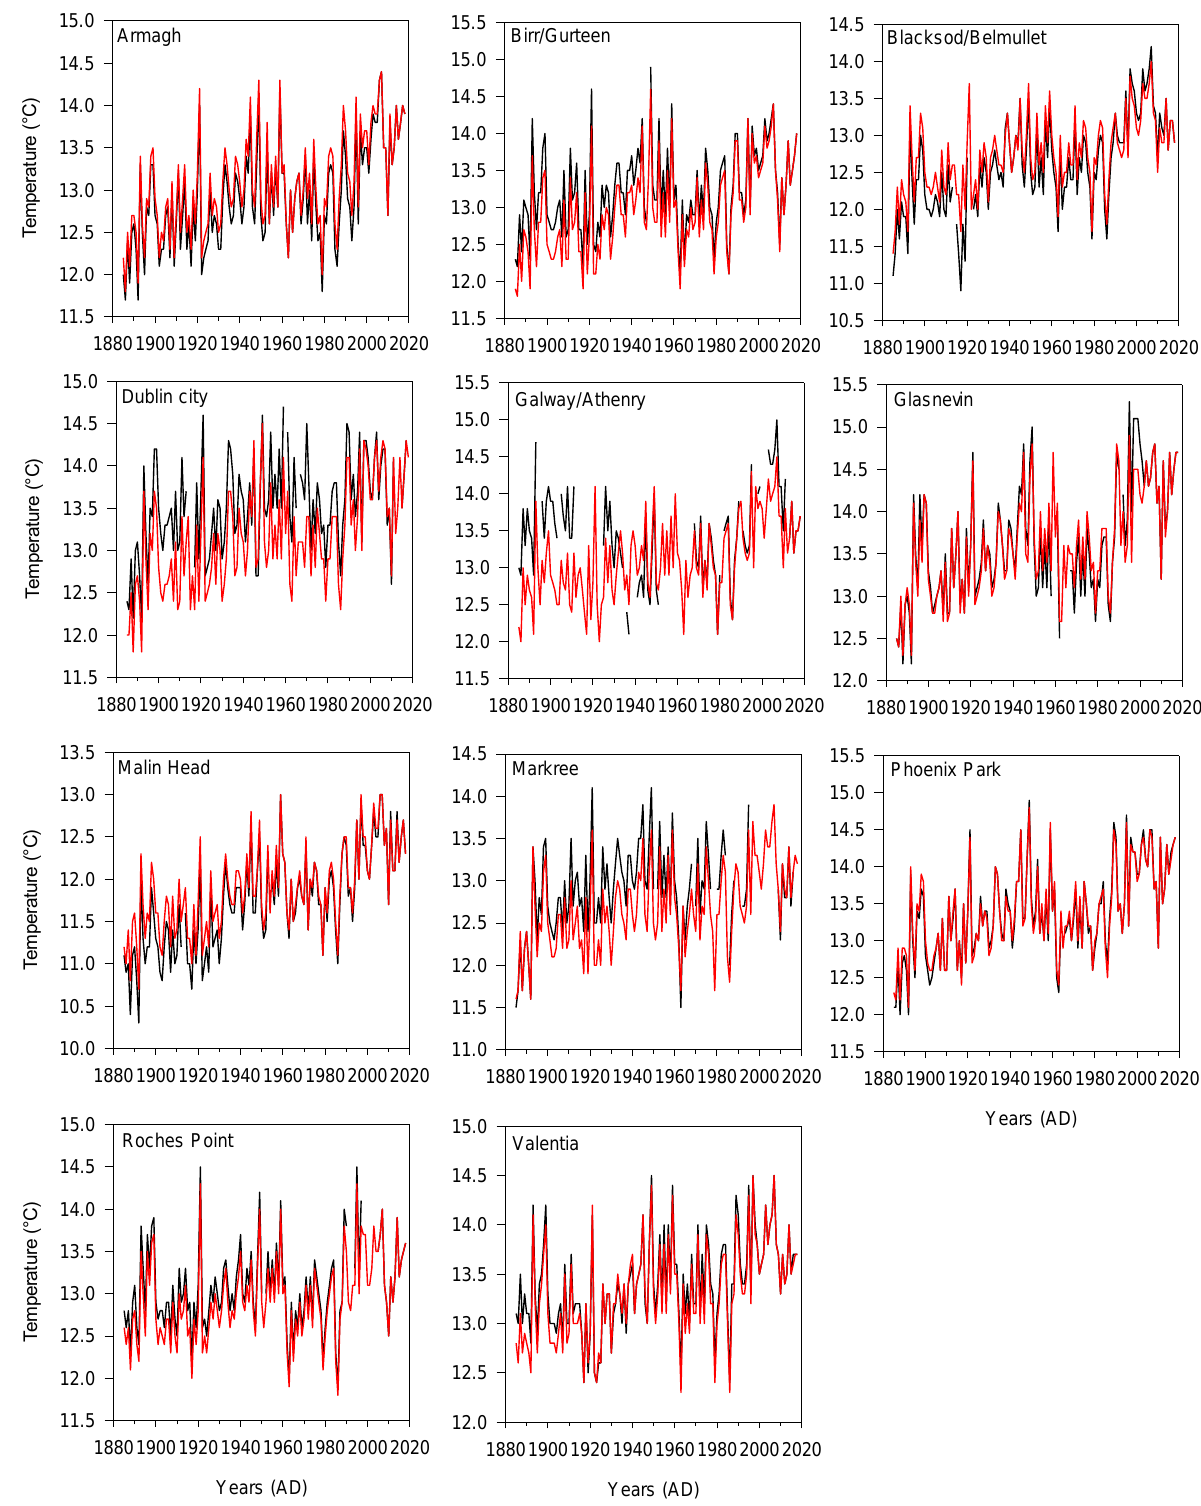
Figure 3. Quality-controlled (black) and homogenised (red) annual MAX series as part of regional networks in 1885 – 2018.